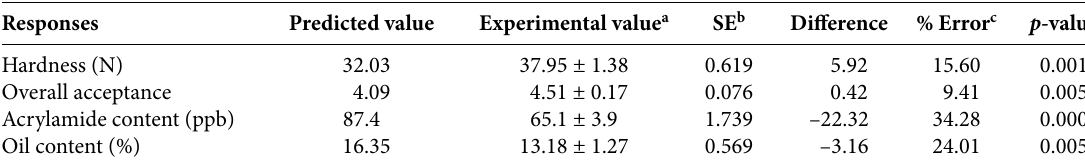
Table 3. Results of statistical analysis for verification the optimization